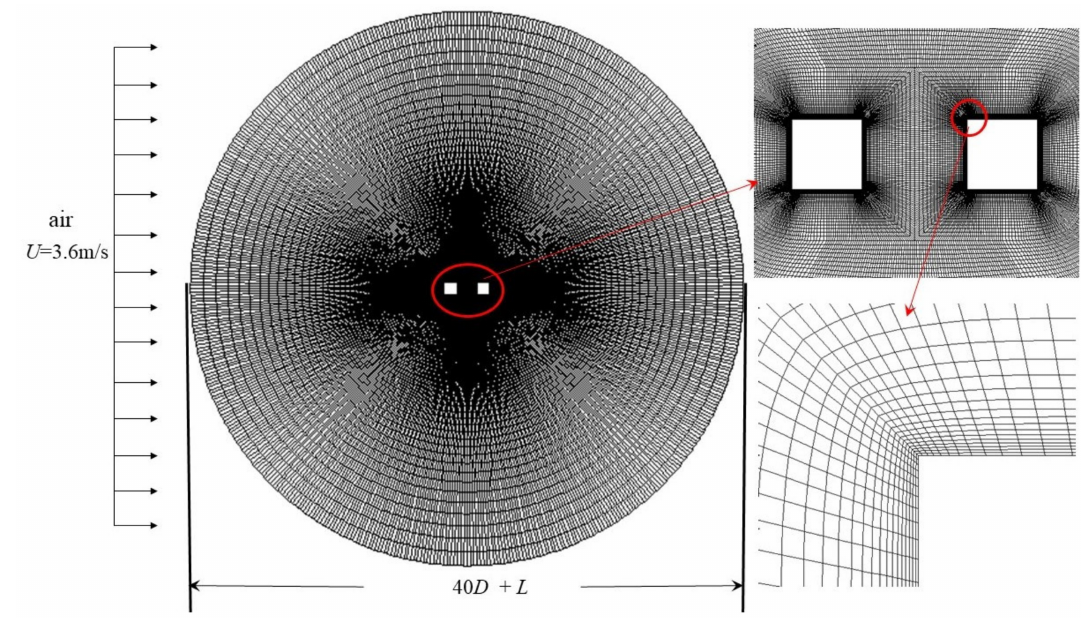
Figure 1. Computational grid of L / D = 2.5. Table 1. Mesh convergence test results when the spacing ratio equals 2.5.